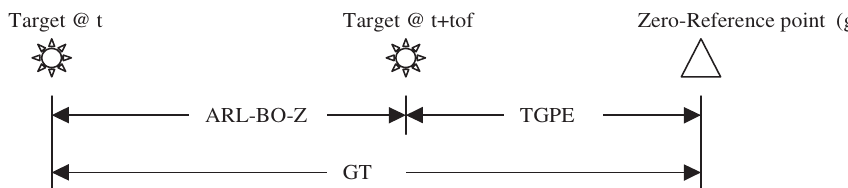
Zero-Reference point (gun)Target @